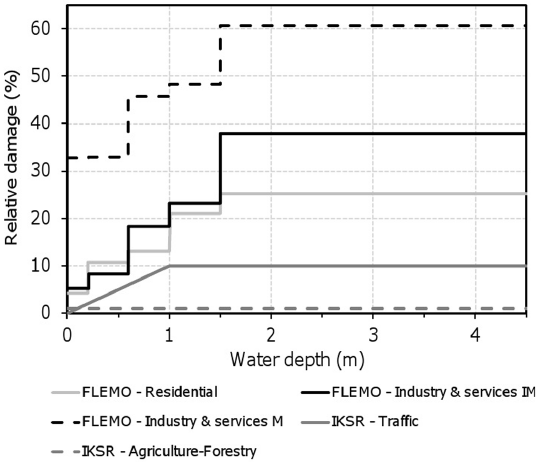
Fig. 8. FLEMO and IKSR damage curves. Black: industrial and commercial areas (dotted line represents mobile assets; continuous line, immobile assets); light grey: residential areas; dark grey: infrastructure; dark grey, dotted line: forestry and agriculture.